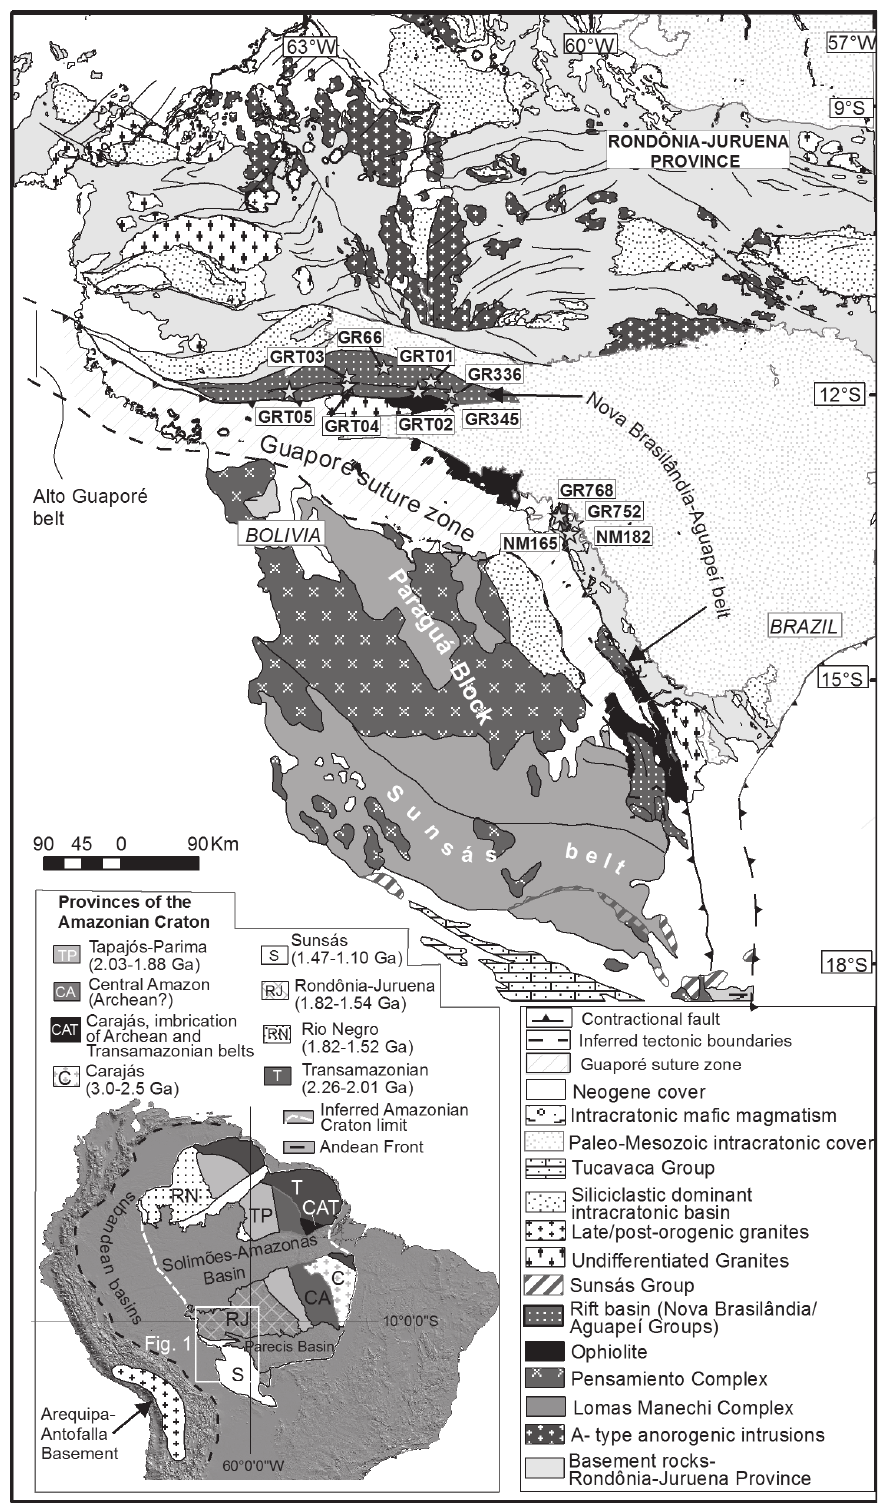
Figure 1 - Simplified map of the southwestern Amazonian craton showing the approximate boundaries of the main Provinces, belts, tectonic elements, lithologic units, and location of dated